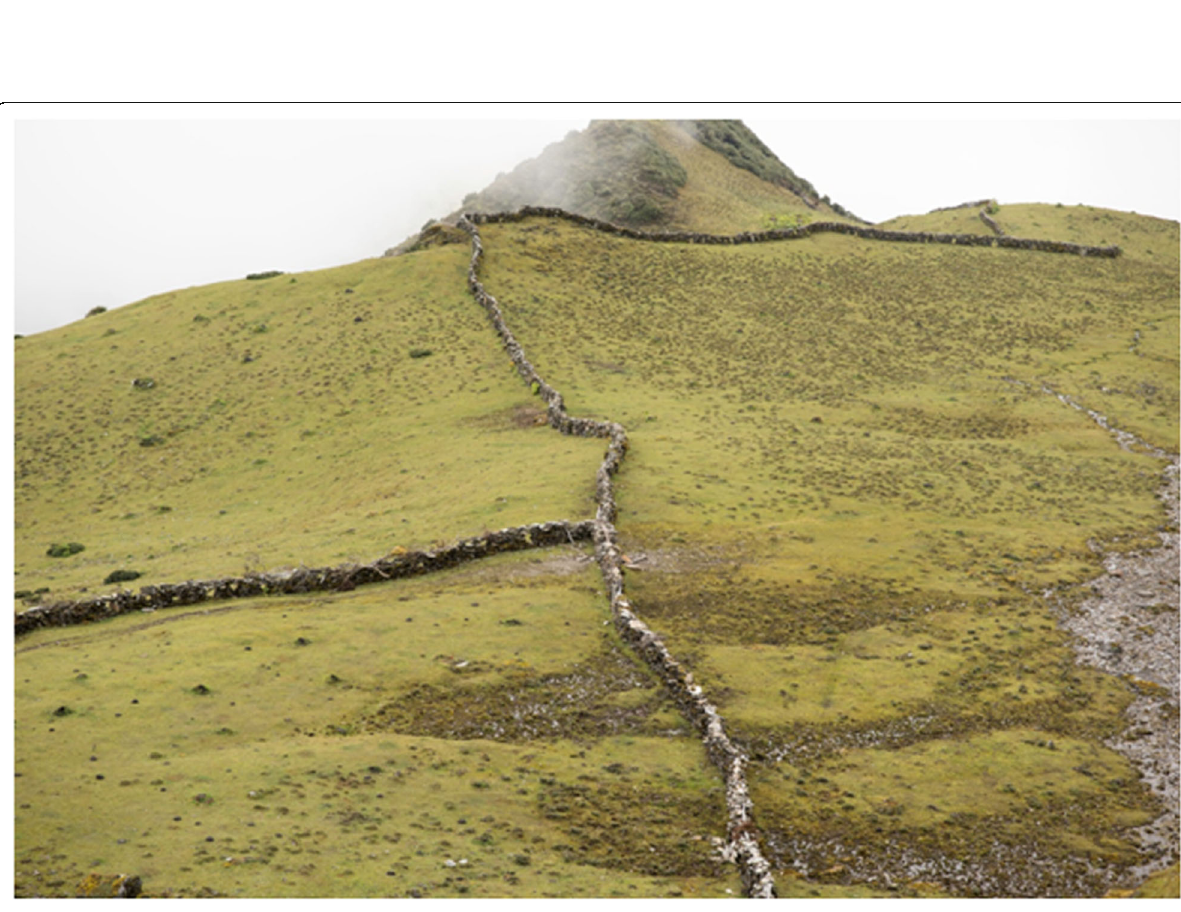
Figure 7 Tsamdro walls demarcating the pastureland boundary between three households in